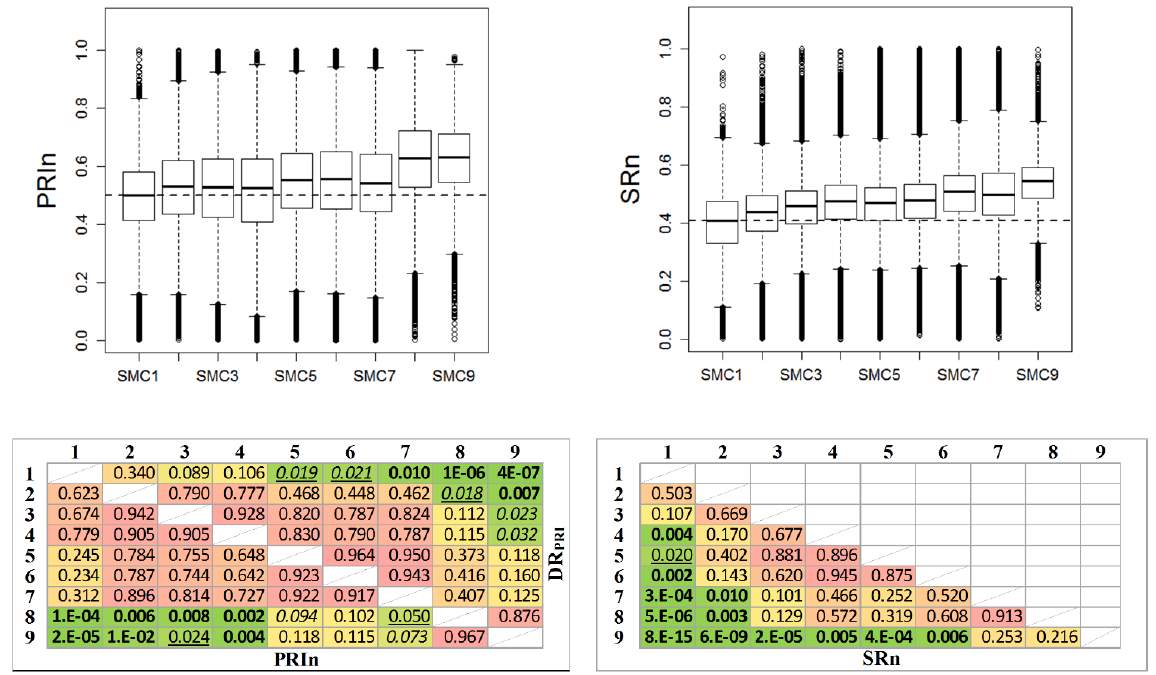
Figure 8. Boxplots of the PRIn and SRn indices per SMC ( top ) and p -value matrices of PRIn, DR PRI and SR from Tukey’s HSD test for each combination of SMCs ( bottom ); color scheme and character styles emphasize the significance levels (dark green/bold: 1%, green/underlined: 5%, yellow/italics: 10%). Table 4. Correlation between the selected spectral indices for the original